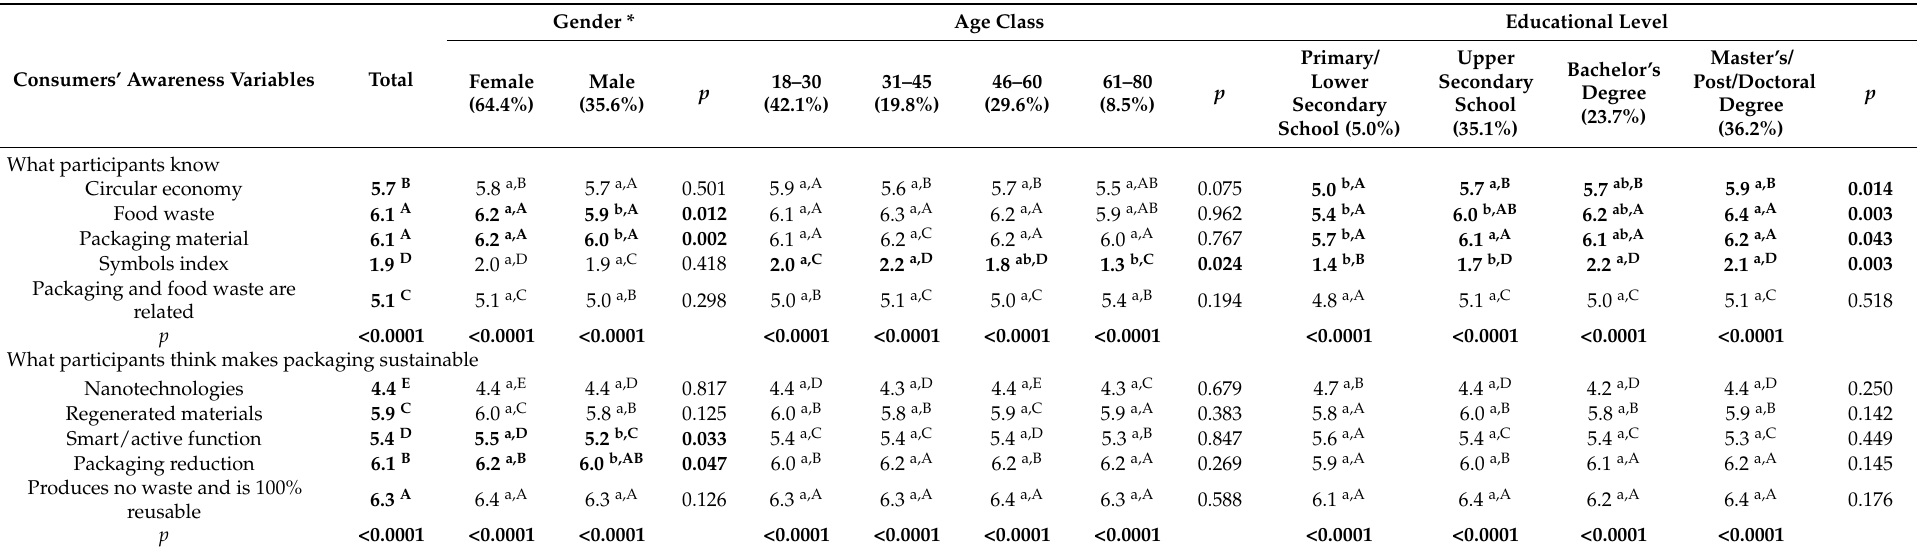
Table 1. Effect of socio-demographic characteristics on consumers’ awareness ( n =